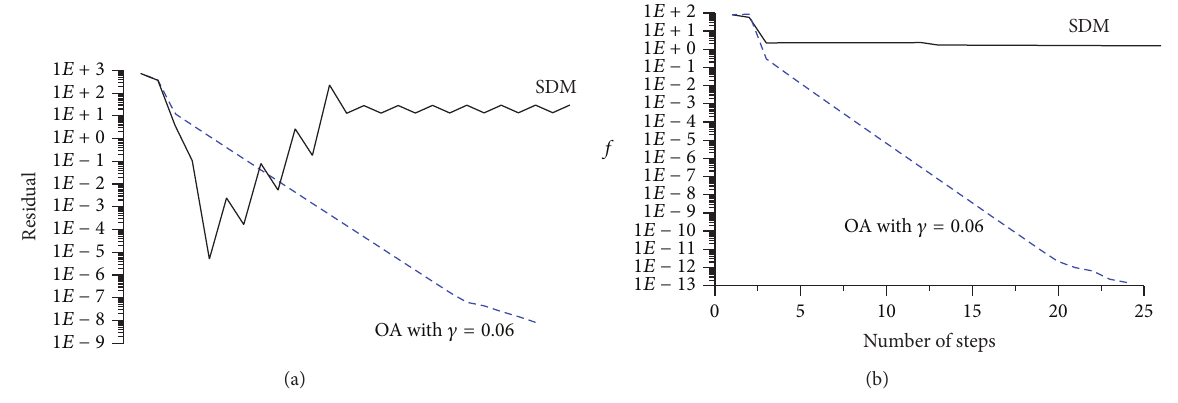
Figure 11: For the minimization of Whitley function comparing (a) residuals and (b) 𝑓 obtained by the SDM and OA, where the SDM is